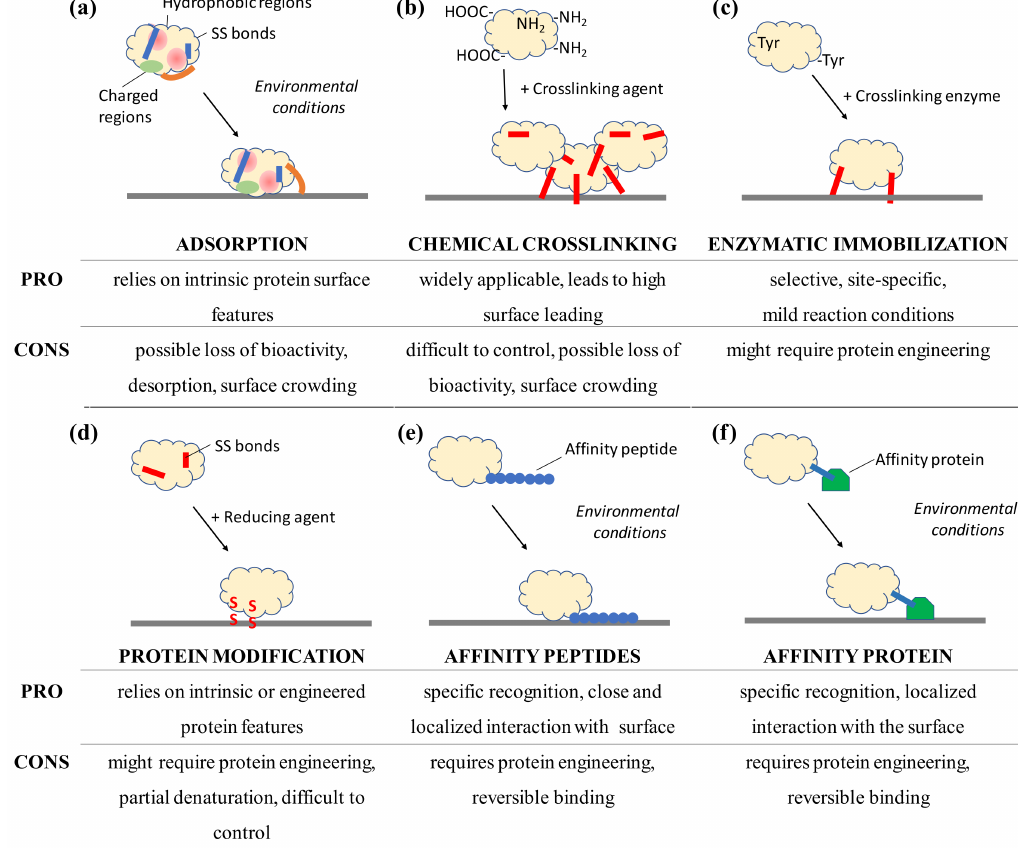
Figure 3. Schematic view of selected immobilization strategies for proteins to surfaces and the advantages and disadvantages to consider after analyzing the protein structure and its surface features. Immobilization by adsorption and affinity rely on environmental conditions, not on the presence of a catalyst or reactive molecule, such as an enzyme, reducing agents or chemical crosslinkers that introduce covalent bonds (in red). Adsorption can lead to conformational changes such as the opening of the hydrophobic lid (orange) which covers the active site of